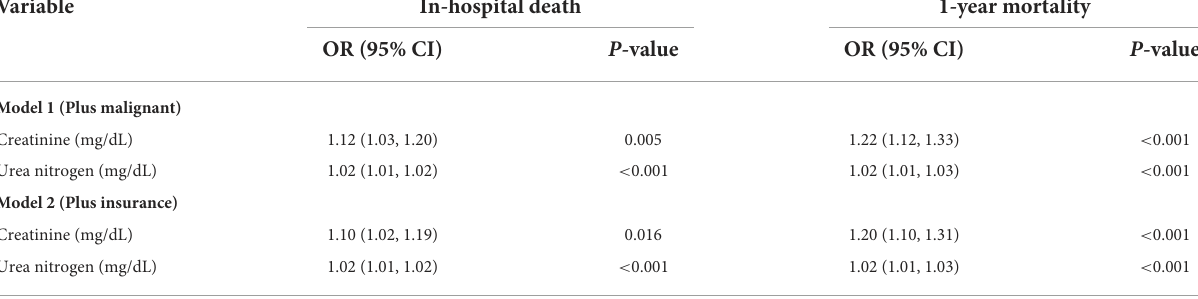
TABLE 3 Sensitivity analysis for associations of blood creatinine and urea nitrogen with hospital mortality and 1-year mortality in ICU patients with intracranial hemorrhage.